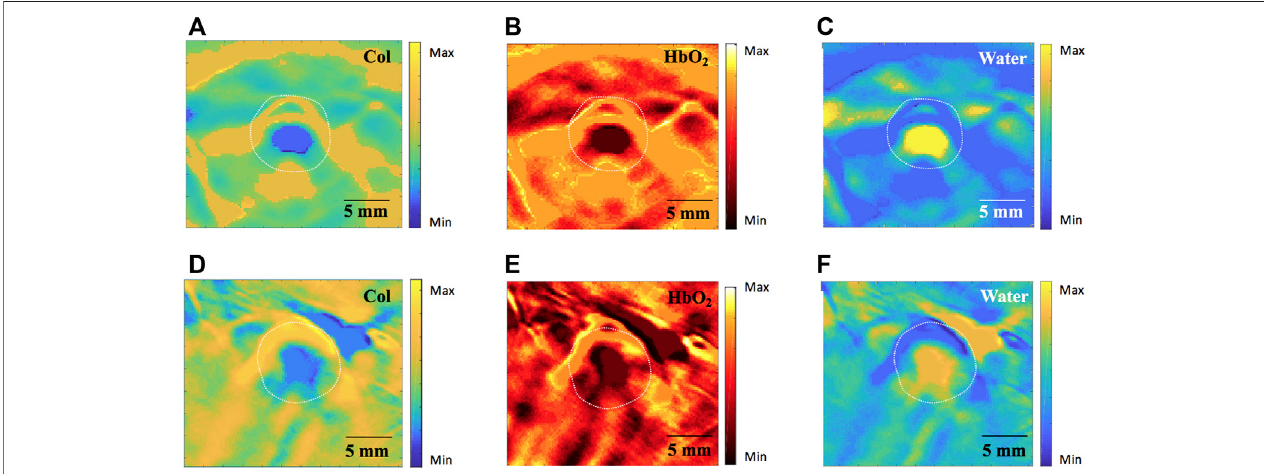
FIGURE 7 | Comparison of tissue functional parameters by MSOT (760nm, 840nm and 910 nm wavelength). (A – C) showing Col, HbO 2 and water distribution in groupB,respectively; (D – F) showingincreasedCol,HbO 2 andwaterdistributioningroupD,respectively.MSOT,multispectraloptoacoustictomography;Col,collagen; HbO 2 , oxygenated hemoglobin. Scale bars are 5 mm